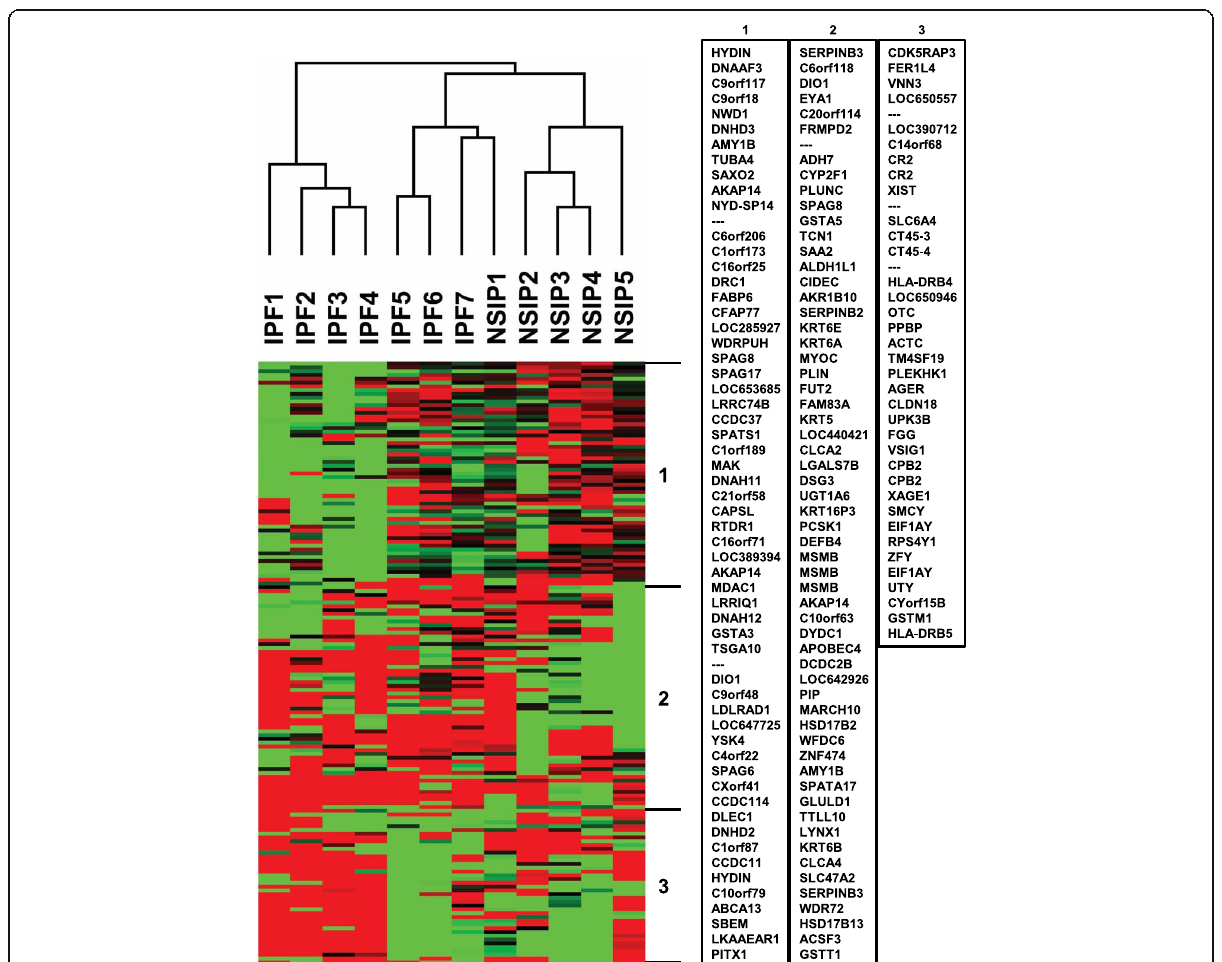
Fig. 1 The dendrogram (top) shows similarities between samples, with shorter branches indicating a higher degree of similarity. The heat map (bottom) shows the expression level of 159 genes in each case. Red: upregulated genes; green: downregulated genes. In the right panel,